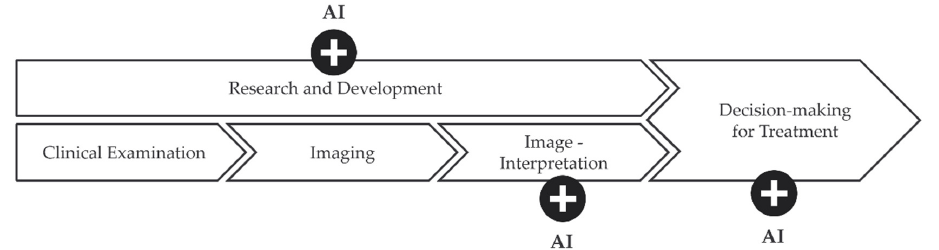
Figure 2. A schematic illustration of the role of artificial intelligence (AI) in orthopedic